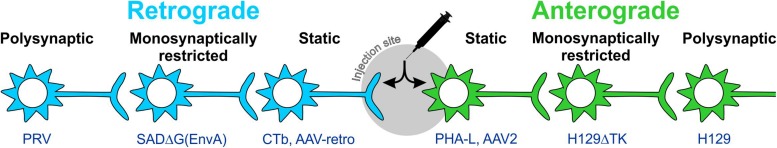
Anterograde and retrograde labeling with static and trans-synaptic tracers. Tracers are categorized as anterograde or retrograde based on their direction of travel within neurons. Anterograde tracers (green) are taken up by neuronal cell bodies at the injection site and travel down the axon to terminal processes. Retrograde tracers (blue) are taken up by terminals and travel back to the cell body. Static tracers remain within the first neurons they enter, while other tracers can spread trans-synaptically and may or may not be monosynaptically restricted. CTb: cholera toxin B subunit; H129ΔTK: tyrosine kinase-deleted H129 herpes; PHA-L: Phaseolus vulgaris-leucoagglutinin; PRV: pseudorabies virus; SADΔG(EnvA): glycoprotein-deleted EnvA-pseudotyped rabies.